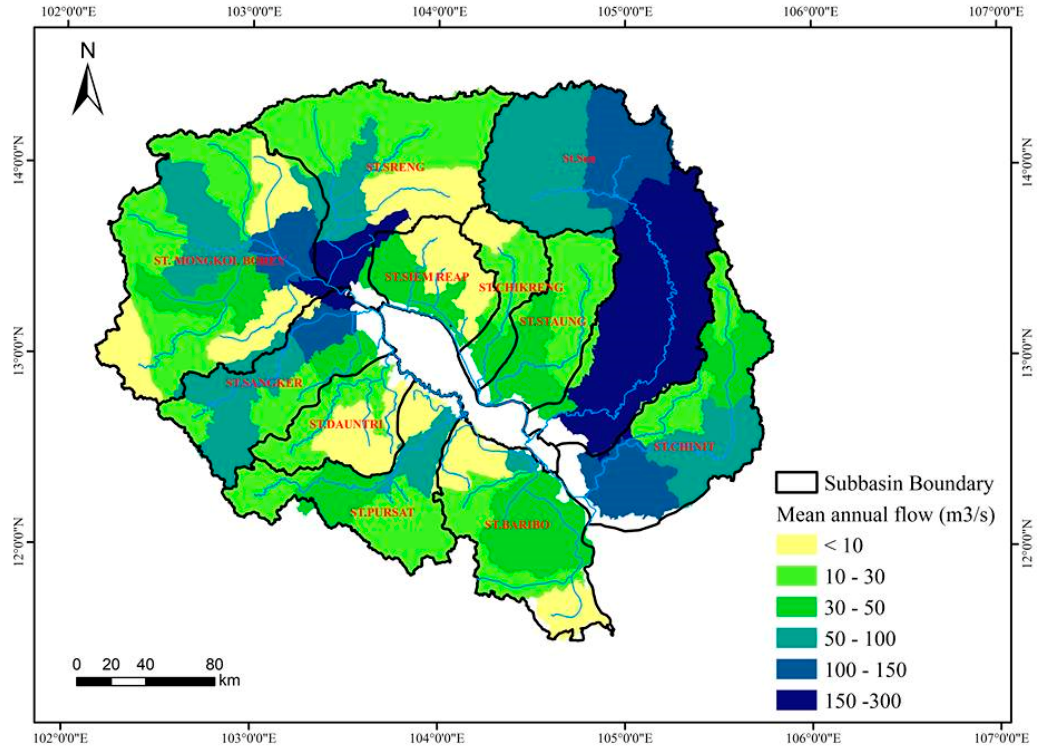
Figure 3. Spatial distribution of the (mean annual) river flow in each sub-basin, simulated from the Soil and Water Assessment Tool (SWAT) model (1985–2015).